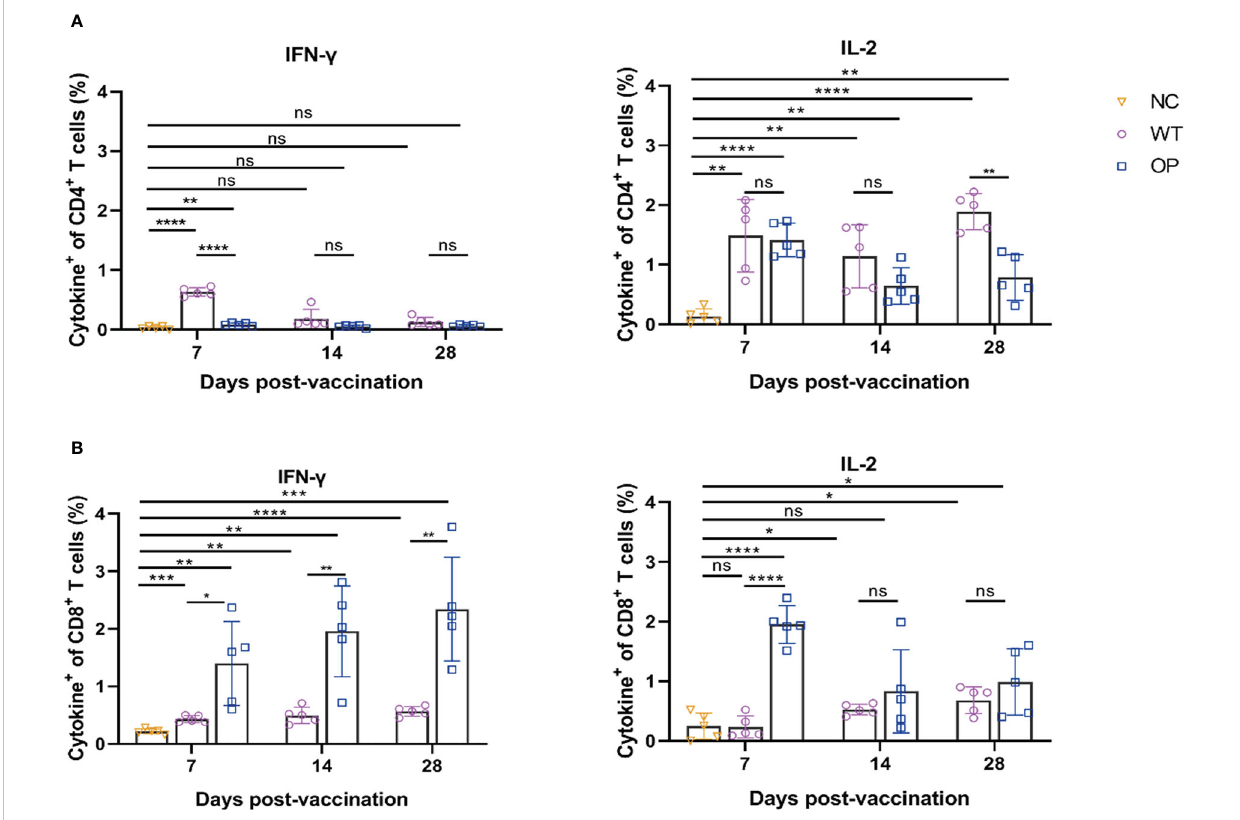
FIGURE 4 CD4 + and CD8 + T-cell responses induced by CHIKV mRNA vaccine. mRNA vaccine was administered to mice and the splenocytes were harvested and analyzed. Percentage of intracellular (A) IFN- g and IL-2 CD4 + T cells, and (B) CD8 + T cells as determined by ICS. n = 5 mice per group; each data point represents the mean number of spots per well. * p < 0.05; ** p < 0.01; *** p < 0.001; **** p < 0.0001; ns: p > 0.05. NC, negative control; WT, wild-type vaccine; OP, codon-optimized vaccine.